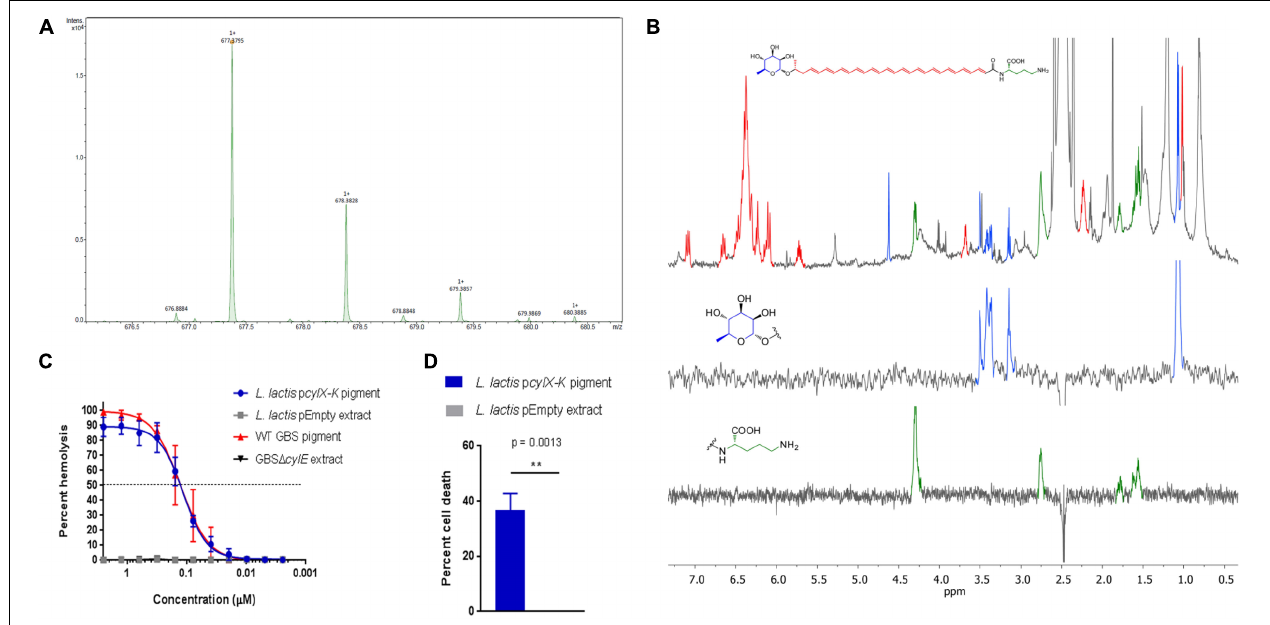
FIGURE 2 | Pigment extracted and purified from L. lactis p cylX-K is identical to Granadaene extracted from WT GBS. (A) High resolution mass spectrometry was performed on pigment extracted from L. lactis p cylX-K and demonstrated an M + H ion at m/z 677.3795, which is associated with an ion formula of C 39 H 53 N 2 O 8 (expected mass of 677.3796). (B) 1 H NMR analyses on L. lactis p cylX-K pigment revealed a signal corresponding to a polyene structure (7.20–5.5 ppm), as well as signals corresponding to an ornithine (4.32, 2.77, 1.80, 1.59, and 1.64 ppm) and a rhamnose (4.63, 3.52, 3.43, 3.39, 3.16, and 1.09 ppm). (C) HPLC-purified pigment from L. lactis p cylX-K or WT GBS in DMSO + trifluoroacetic acid + starch (DTS) was added to human erythrocytes in twofold serial dilutions starting from 2.5 to 0.0024 µ M for 1 h. As controls, equivalent amounts of extracts from L. lactis pEmpty and from non-pigmented/hemolytic GBS (cid:49) cylE were tested. Mean and standard error from three independent experiments performed in triplicate are shown. The EC 50 for L. lactis p cylX-K pigment (0.128 µ M, 95% CI: 0.108, 0.153) is no different than that of WT GBS pigment/Granadaene (0.127 µ M, 95% CI: 0.100, 0.162). (D) Primary human neutrophils were incubated with 0.5 µ M purified pigment from L. lactis p cylX-K for 4 h at 37 ◦ C. As a control, neutrophils were treated with an equivalent amount of L. lactis pEmpty extract. Neutrophil death was measured by LDH release into cell supernatants relative to Triton X-100 and PBS-only controls. Mean and standard error from three independent experiments performed in triplicate are shown. An unpaired t -test was performed, and p = 0.0013. ∗∗ indicates that p <